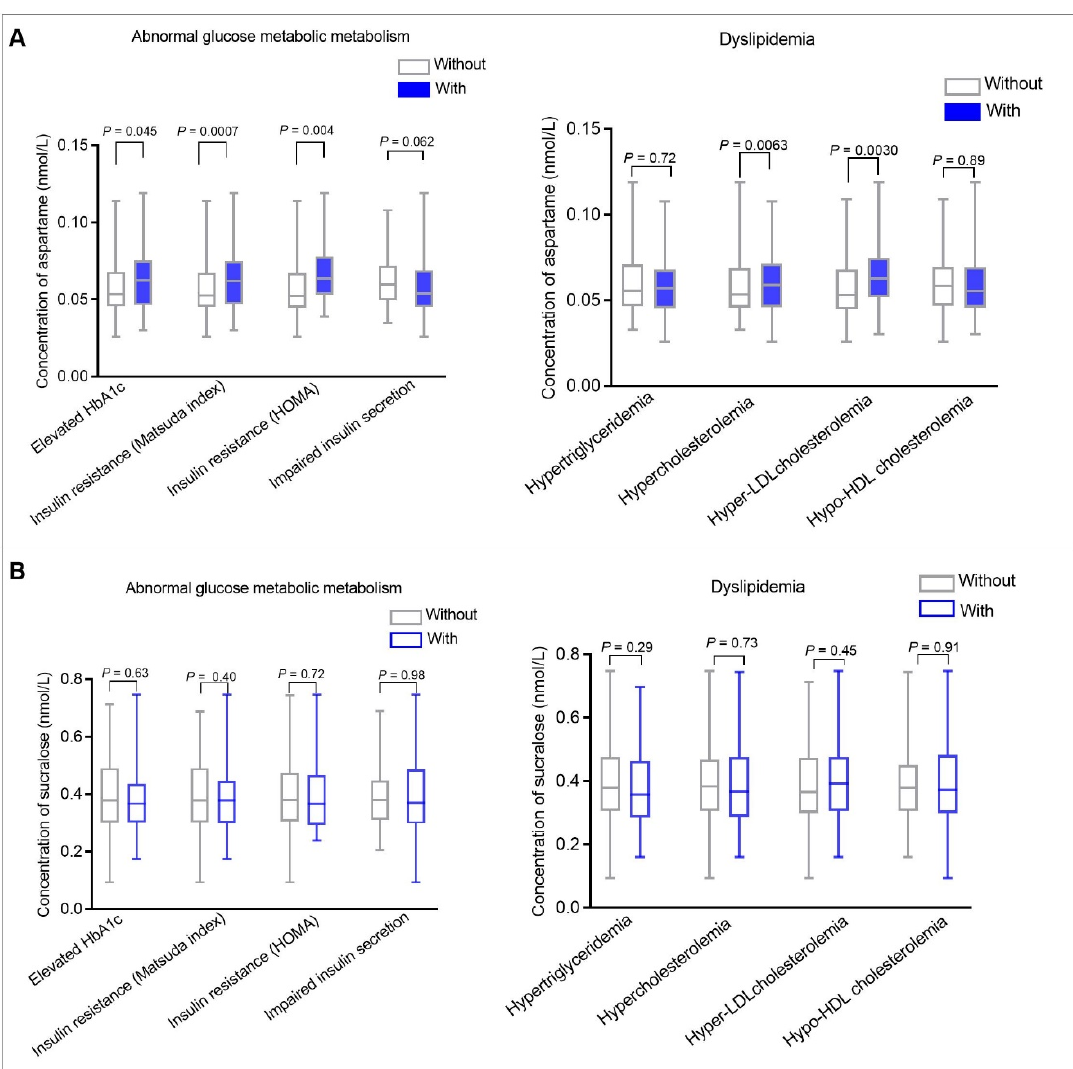
Figure 1. Box plot comparing serum aspartame ( A ) and sucralose ( B ) levels among all participants with and without abnormal glucose metabolism and dyslipidemia during pregnancy. The left panel ( A ) compares serum aspartame levels in women with and without abnormal glucose metabolism. The right panel ( A ) compares serum aspartame levels in women with and without dyslipidemia. The left panel ( B ) compares serum sucralose levels in women with and without abnormal glucose metabolism. The right panel ( B ) compares serum sucralose levels in women with and without dyslipidemia. Abnormal glucose metabolism during pregnancy included elevated HbA1c, insulin resistance, and impaired insulin secretion. Elevated HbA1c was defined as ≥ 5.1% (the upper tertile of HbA1c). Insulin resistance was defined as ≤ 8.00 (the upper tertile of Matsuda ISI) or ≥ 2.4 (the lower tertile of HOMA-IR). Impaired insulin secretion was defined as ≤ 107.10 (the lower tertile of HOMA-β index). Dyslipidemia during pregnancy included hypertriglyceridemia, hypercholesterolemia, hyper- LDL cholesterolemia, and hypo-HDL cholesterolemia. Hypertriglyceridemia was defined as ≥ 1.9 mmol/L (the upper tertile of triglycerides). Hypercholesterolemia was defined as ≥ 5.73 mmol/L (the upper tertile of total cholesterol). Hyper-LDL cholesterolemia was defined as ≥ 3.08 mmol/L (the upper tertile of LDL-cholesterol). Hypo-HDL cholesterolemia was defined as ≤ 2.89 mmol/L (the lower tertile of HDL-cholesterol). Wilcoxon rank-sum tests were used to compare serum aspartame and sucralose levels among all participants with and without abnormal glucose metabolism and dyslipidemia. p values less than 0.05 were considered statistically